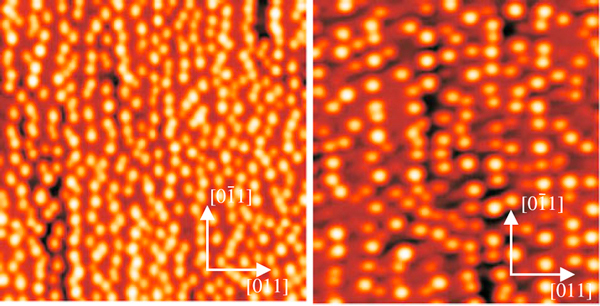
One layer AFM 1 × 1 μm image of In0.4Ga0.6As QDs in samples grown under different conditions. Sample A (left) shows 1D chain-like ordering along the [01¯1] direction. Sample B (right) shows mostly isotropic or randomized dot distribution in the (001) plane.